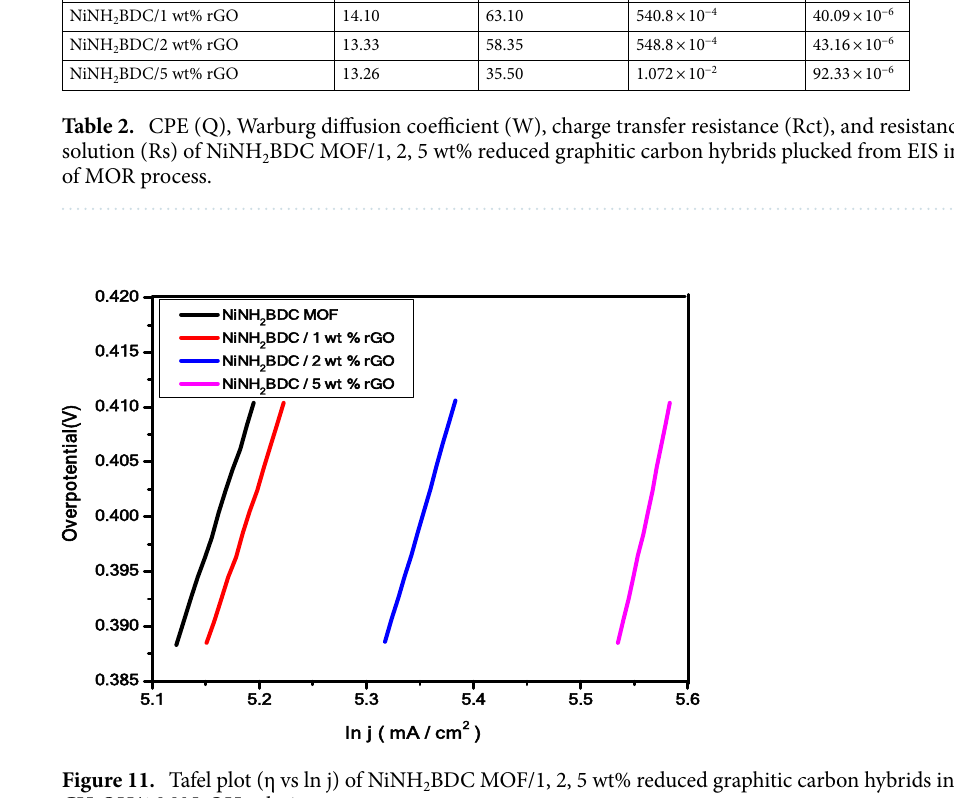
Figure 11. Tafel plot (η vs ln j) of NiNH 2 BDC MOF/1, 2, 5 wt% reduced graphitic carbon hybrids in 3 M CH 3 OH/1 M NaOH solution.